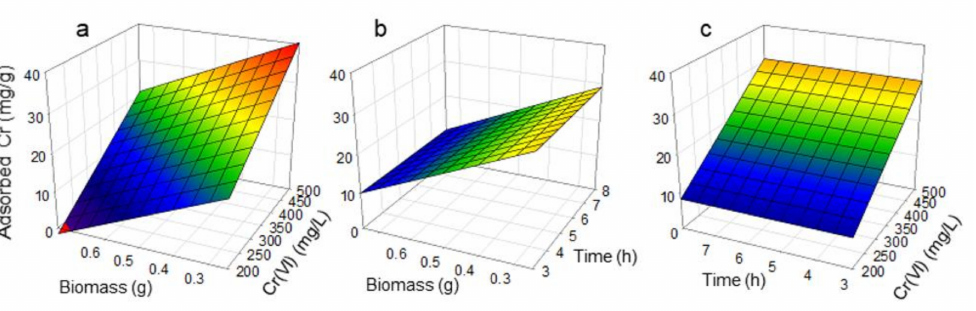
Figure 2. Surface response of the linear model in Equation (10) for the sorption capacity q of Cr in spirulina biomass versus ( a ) Cr concentration and biomass dose, ( b ) contact time and biomass dose, and ( c ) contact time and Cr